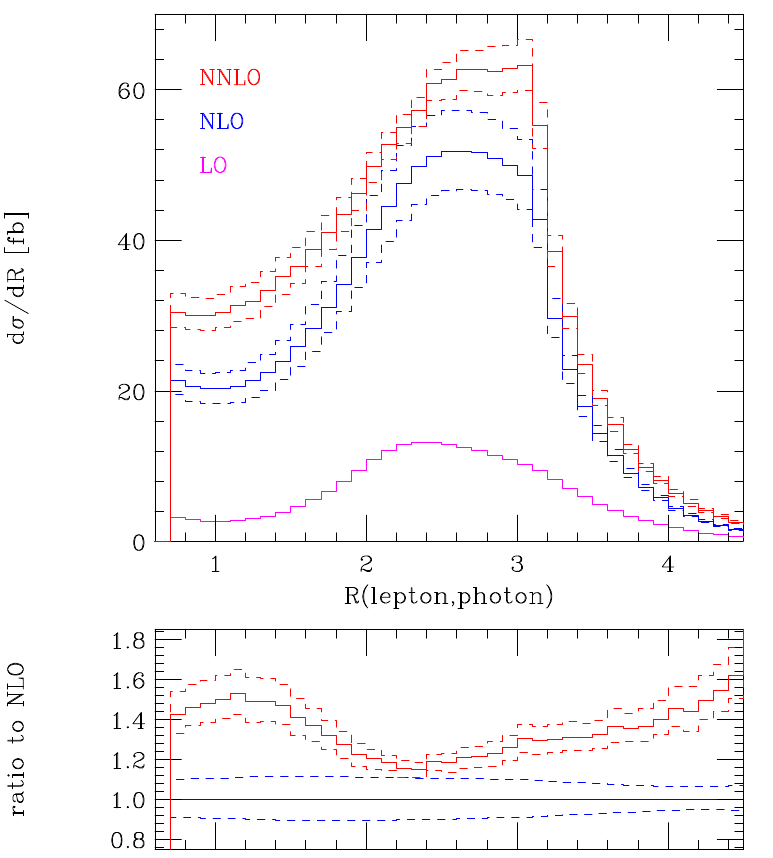
Figure 6 . ∆ R ( ‘, γ ) distribution at 13 TeV. The NNLO and NLO histograms display the error estimates, obtained via a 9-point scale variation, and the lower panel displays the ratio of the NLO and NNLO predictions to the central NLO